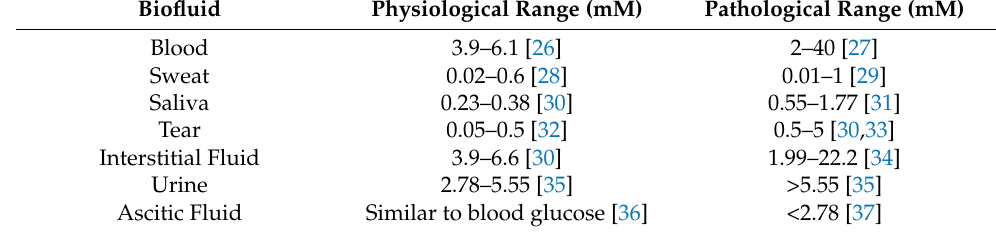
Table 1. Summary of glucose concentrations under physiological and pathological conditions.